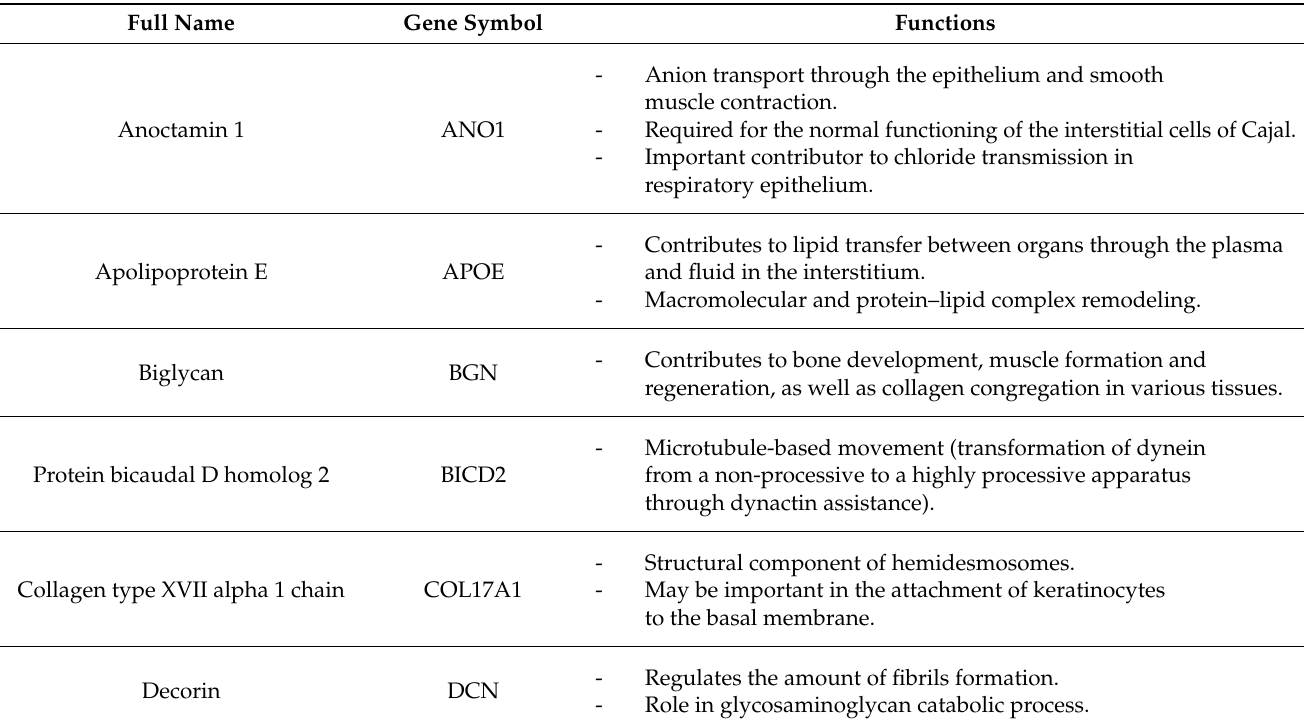
Table 3. Functions of identified and investigated genes involved in stress urinary